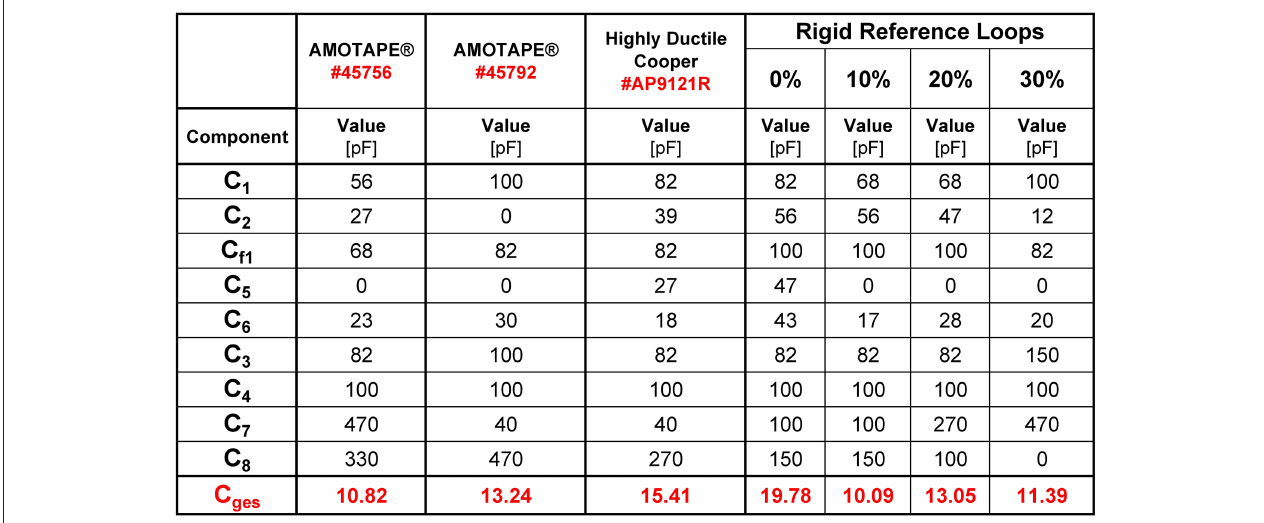
FIGURE 12 | Component values for all built rigid and stretchable